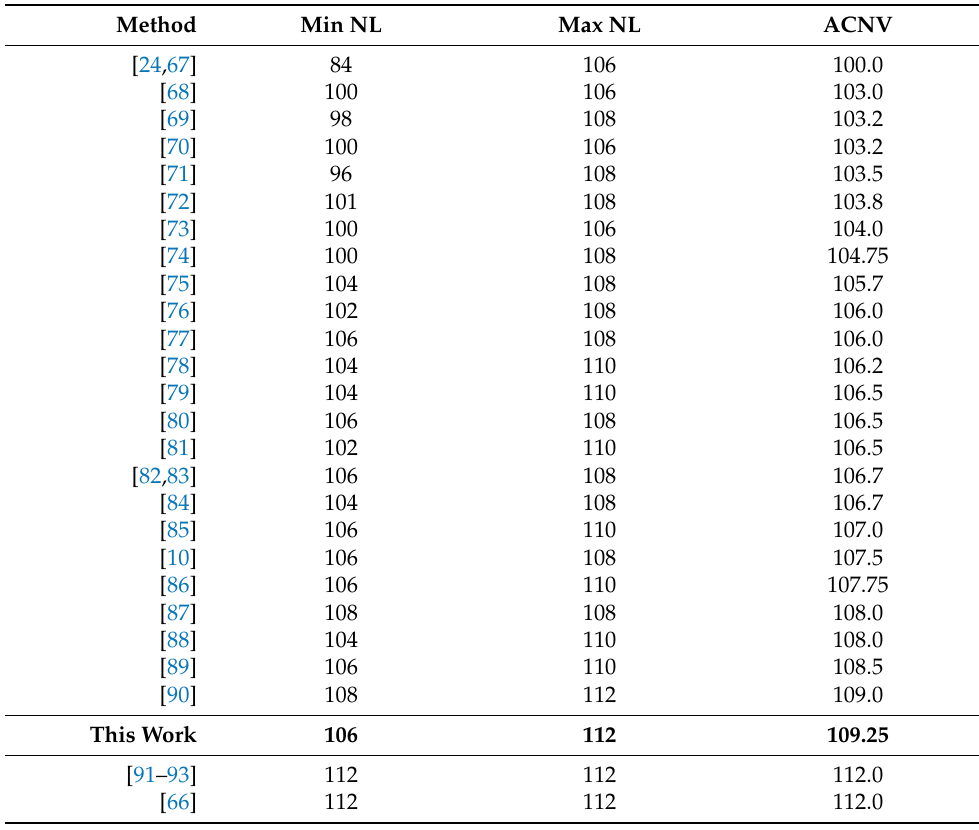
Table 5. Experimental